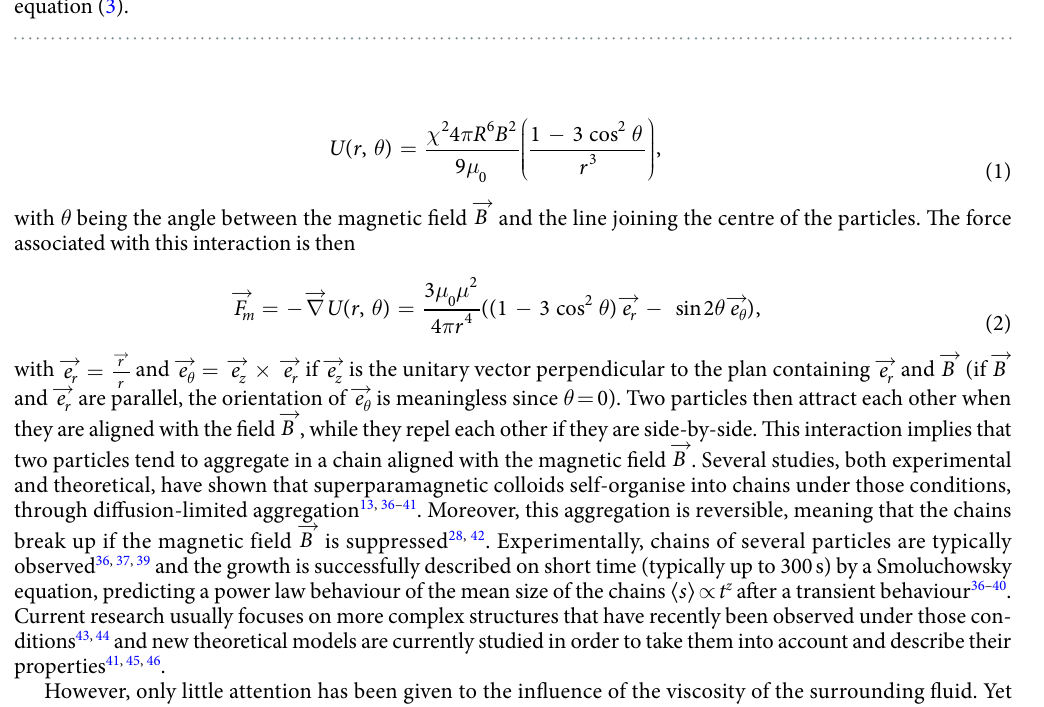
Figure 1. Evolution of the chain formation along scaled time as observed from one of our experiments (left side of each picture) and one of our simulations (right side of each picture). The pictures are part of images obtained with a magnetic field B = 12 G. One can observe the formation of chains aligned with the external magnetic field and a qualitative similarity between experiments and simulations. The characteristic time t B is defined in equation